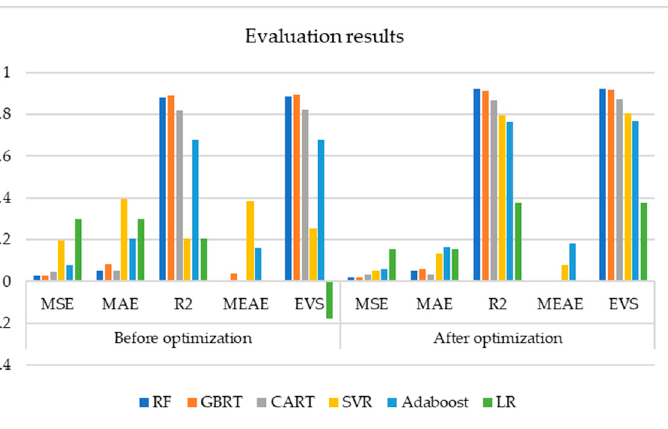
Figure 9. Evaluation results of six models before and after optimization.